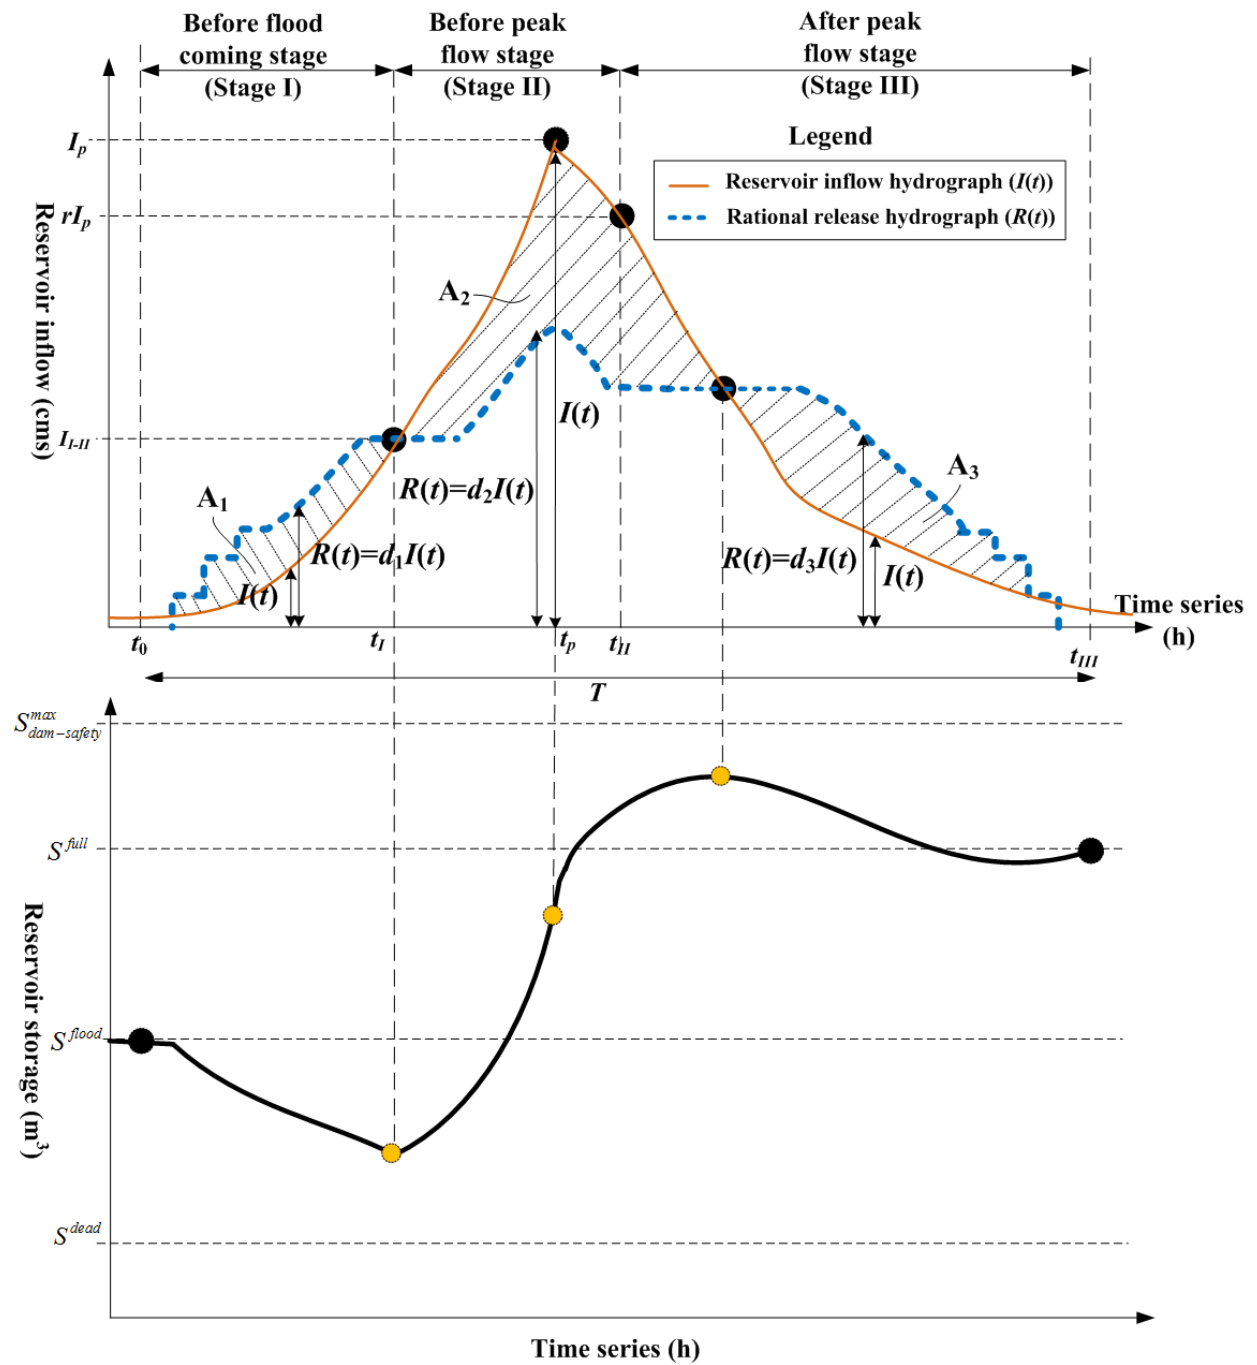
Figure 2. Schematic diagram of the flood operating mechanism of different stages in conjunction with the reservoir